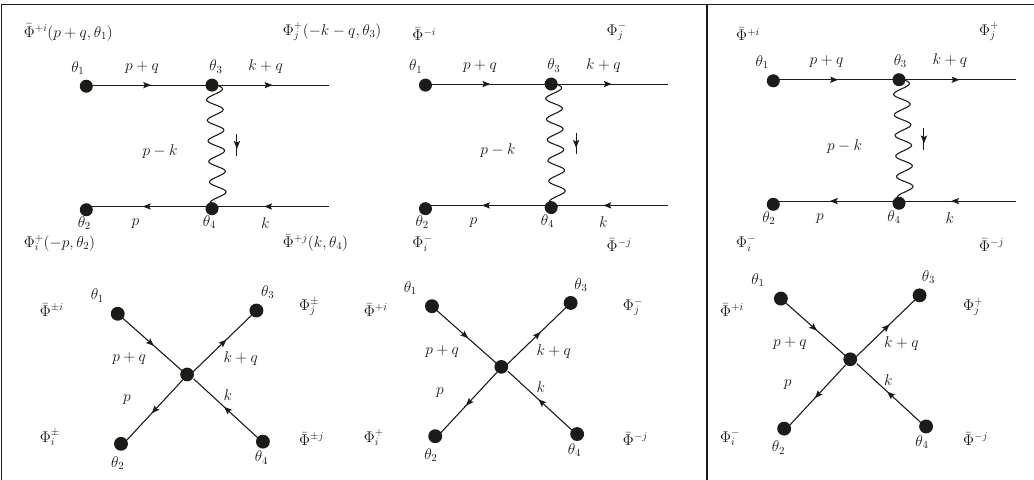
Figure 3 . In the above, the (cid:12)rst block encloses the diagrams where the total SO(2) R charge of the in/out states respectively is zero. The second block constitutes diagrams that have in/out states with charge (cid:6) 1. See appendix A.3 for the notations and conventions. The color lines (cid:13)ow from anti-fundamentals to